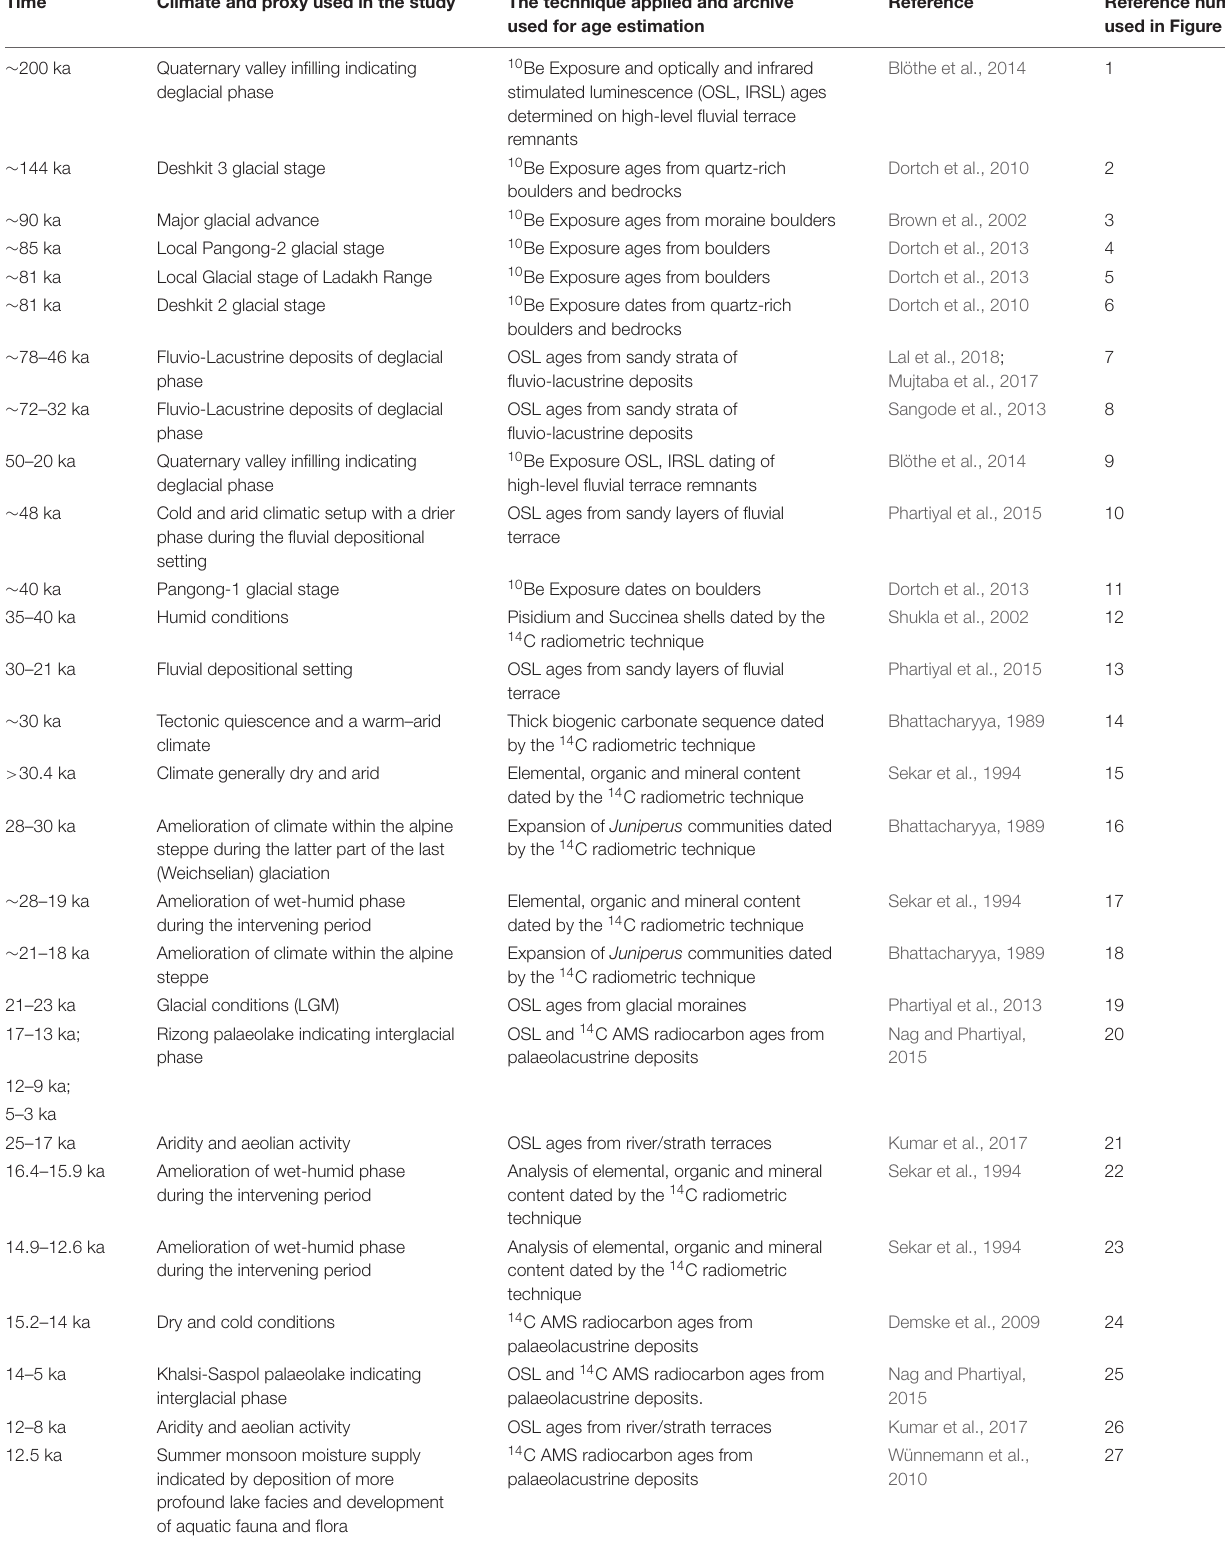
TABLE 1 | Summary table of climatic history in the trans -Himalayan region (Ladakh and Spiti Valley). Time Climate and proxy used in the study The technique applied and archive